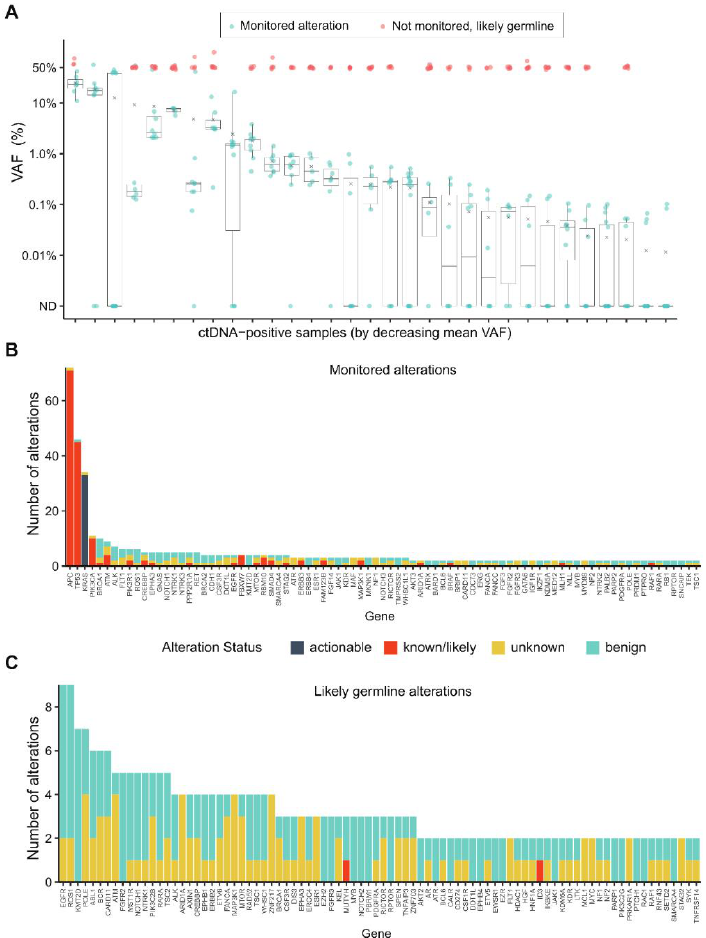
Figure 3. ( A ) Variant Allele Frequency (VAF) of each monitored alteration in ctDNA-positive samples at the postsurgical time point (T1) showing monitored variants (blue points) for each sample, as well as non-monitored variants with VAF ≥ 45% that are likely of germline origin (red points). Boxplots represent the distribution of monitored alterations only. ( B ) Long-tail plot of monitored alterations according to variant status and gene name. ( C ) Long-tail plot of non-monitored alterations of likely germline origin according to variant status and gene name.